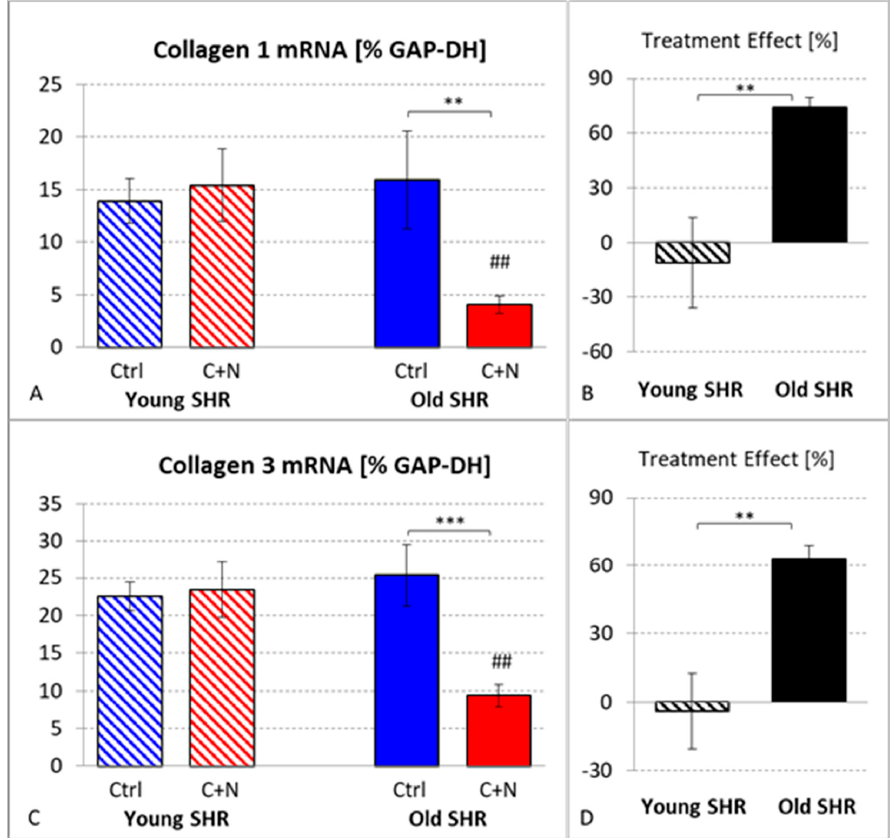
Figure 4. ( A ) mRNA expression of collagen type I in untreated (Ctrl) and treated (C+N) young and old SHRs. ( B ) Treatment effects on Coll 1 in young and old SHRs (in % of corresponding average Ctrl value). ( C ) mRNA expression of collagen type III in untreated (Ctrl) and treated (C+N) young and old SHRs. ( D ) Treatment effects on Coll 3 in young and old SHRs (in % of corresponding average Ctrl value). Significance marks: ⎾ * ⏋ significant difference between marked groups, ** p < 0.01, *** p < 0.001; ## significant difference to corresponding young SHR group, p < 0.01.